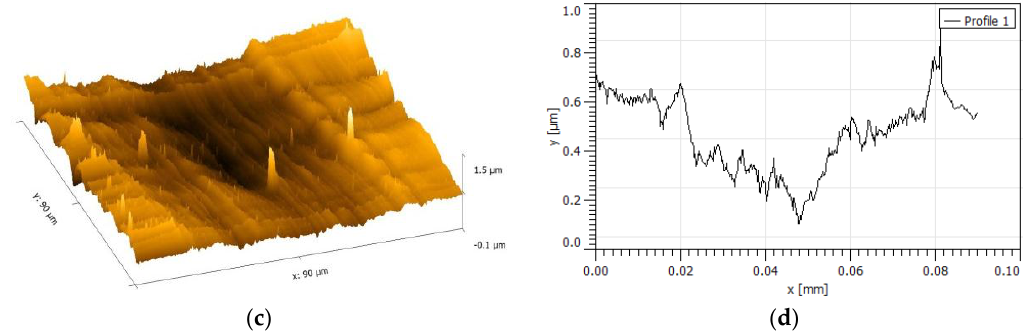
Figure 9. Tracks observed in AFM. Ti 6 Al 4 V-BM track: ( a ) surface and ( b ) profile; and Ti 6 Al 4 V-LR: ( c ) surface and ( d ) profile.